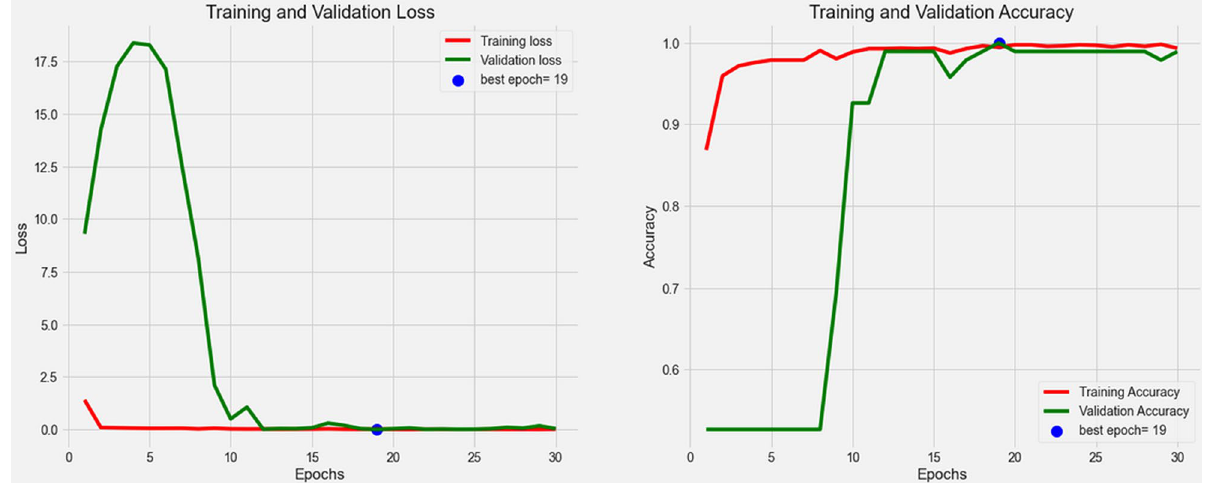
Figure 5. The training and validation process of the DCNN model. Source: Authors’ construction using Jupyter Notebook, and Python version